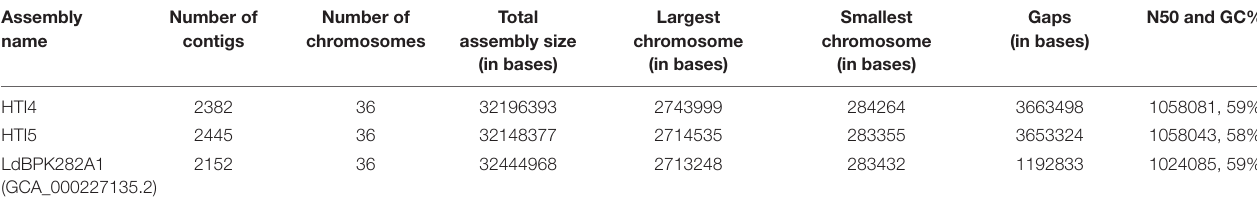
TABLE 1A | Summary of assembly statistics for early passage (HTI4), late passage (HTI5) and Genbank Leishmania donovani LdBPK282A1 genomes.